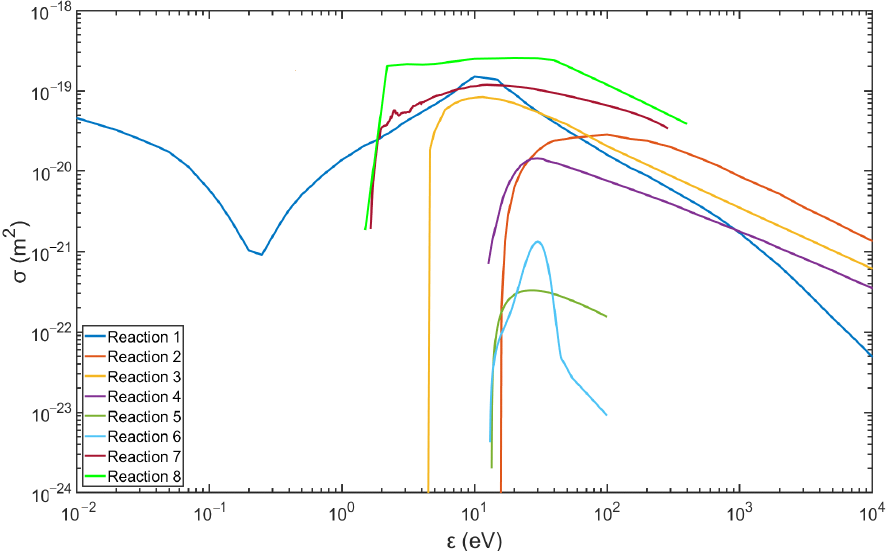
Figure 3. Collision cross-section of argon plasma reactions (data are from the databases listed in Table 4).